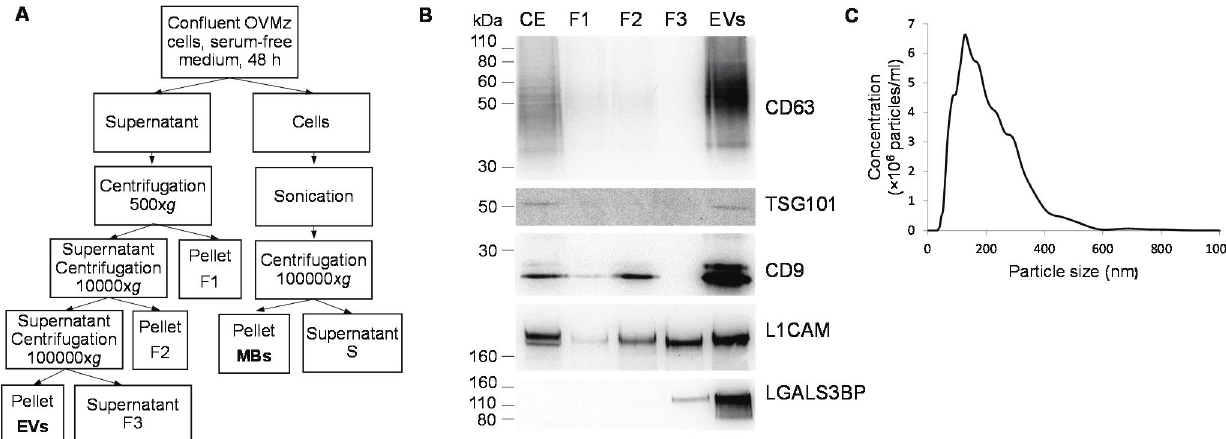
Figure 1. Isolation of EVs from OVMz cells. ( A ) Diagrammatic representation of the isolation procedure; ( B ) Immunoblotting of EVs markers in cellular extracts (CE), fractions